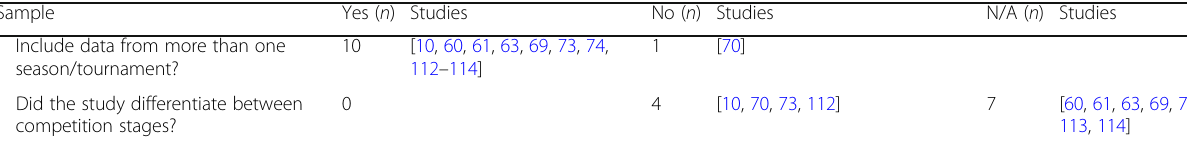
Table 3 A summary of the types of samples selected (Continued) Sample Yes ( n ) Studies No ( n ) Studies N/A ( n ) Studies Include data from more than one season/tournament?